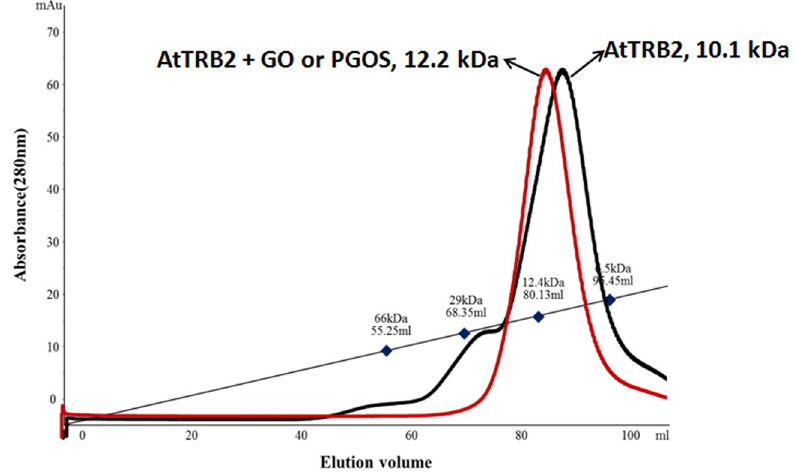
Figure 7. Size-exclusion chromatography (SEC) binding assay of AtTRB2 and GO.